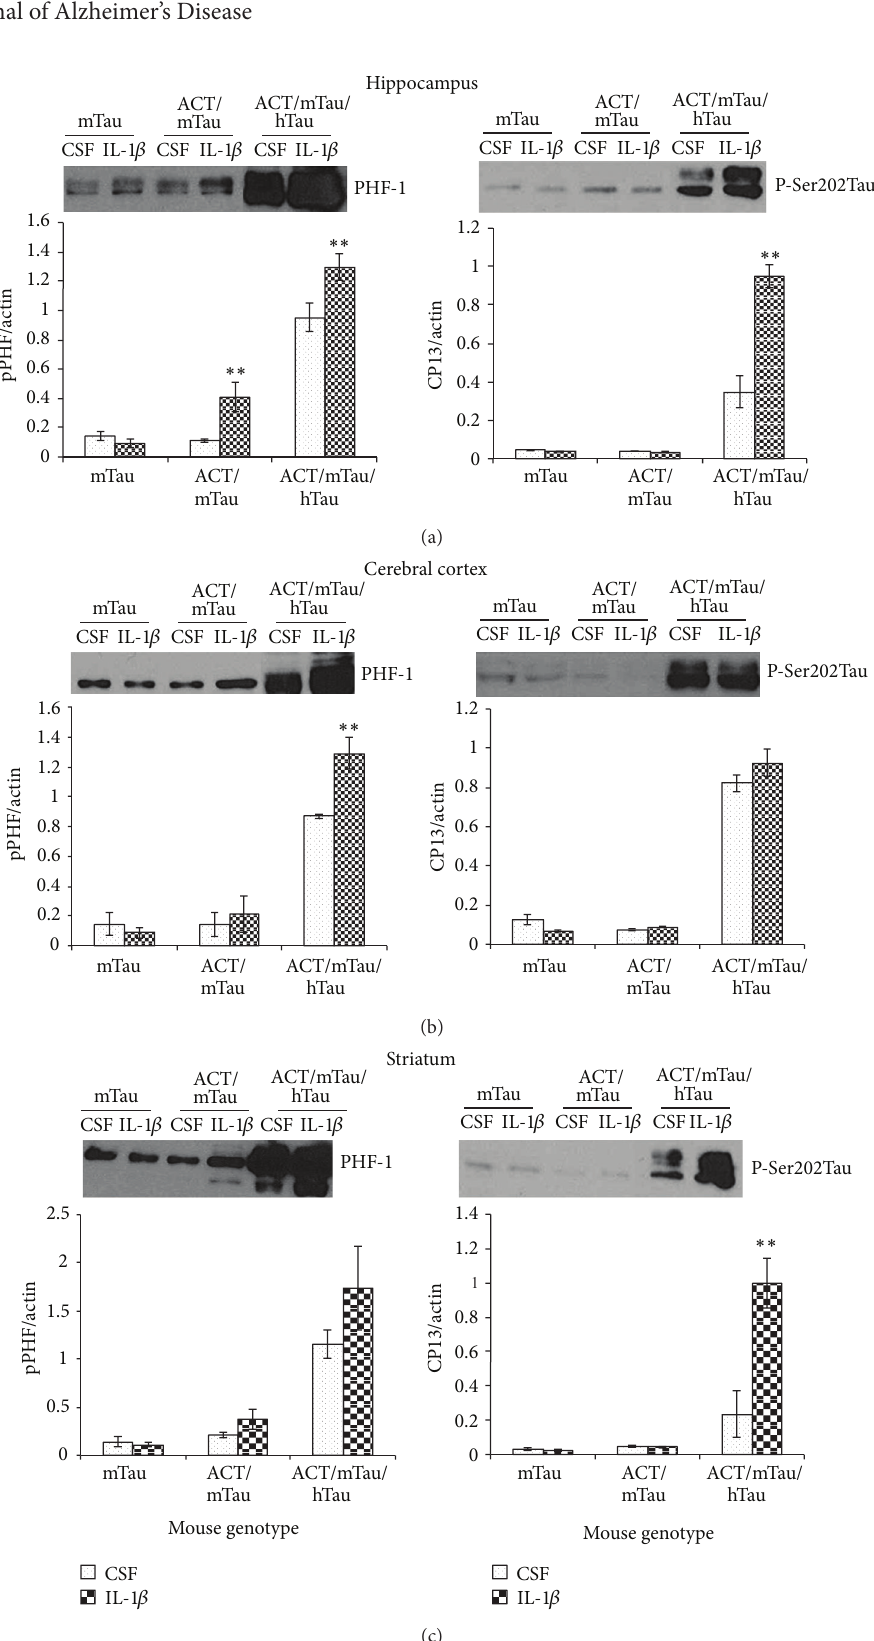
Figure 2: Inflammatory proteins induce tau hyperphosphorylation in AD-associated regions in the brain: PHF-1 and p-Ser202 Tau phosphorylation in different brain regions—hippocampus (a), cerebral cortex (b), and striatum (c) from control mice (mTau), and mouse expressing ACT/mTau and ACT/mTau/hTau transgenes injected with CSF and IL-1 𝛽 (1ng/10 𝜇 L) ∗ 𝑃 < 0.05 , ∗∗ 𝑃 < 0.01 (calculated from aCSF versus IL-1 𝛽 treated group). Values were normalized to actin levels. The blot above each bar graph shows a representative western blot showing corresponding P-tau in the samples from different mice. The data was collected from four independent mice from each genotype